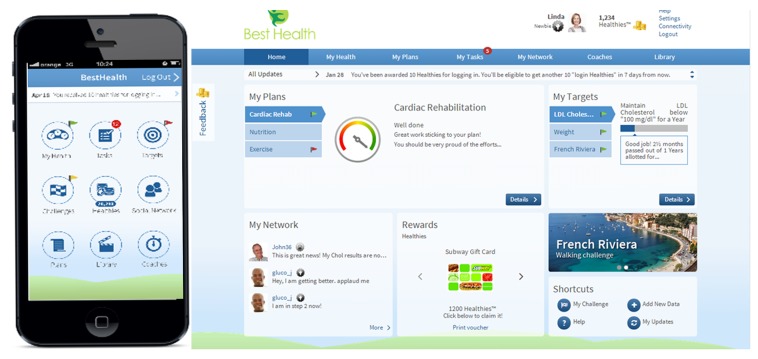
Smartphone (left) and online (right) versions of the digital health intervention.The online version (right) shows the “Lifestyle” dashboard comprised of CVD risk factors such as smoking status, physical activity, dietary habits, and medication adherence. Patients are able to learn about these habits individually, and note their progress over time. The smartphone version (left) demonstrates the home page of the mobile platform allowing patients to navigate to any portion of the program and enter their own data.